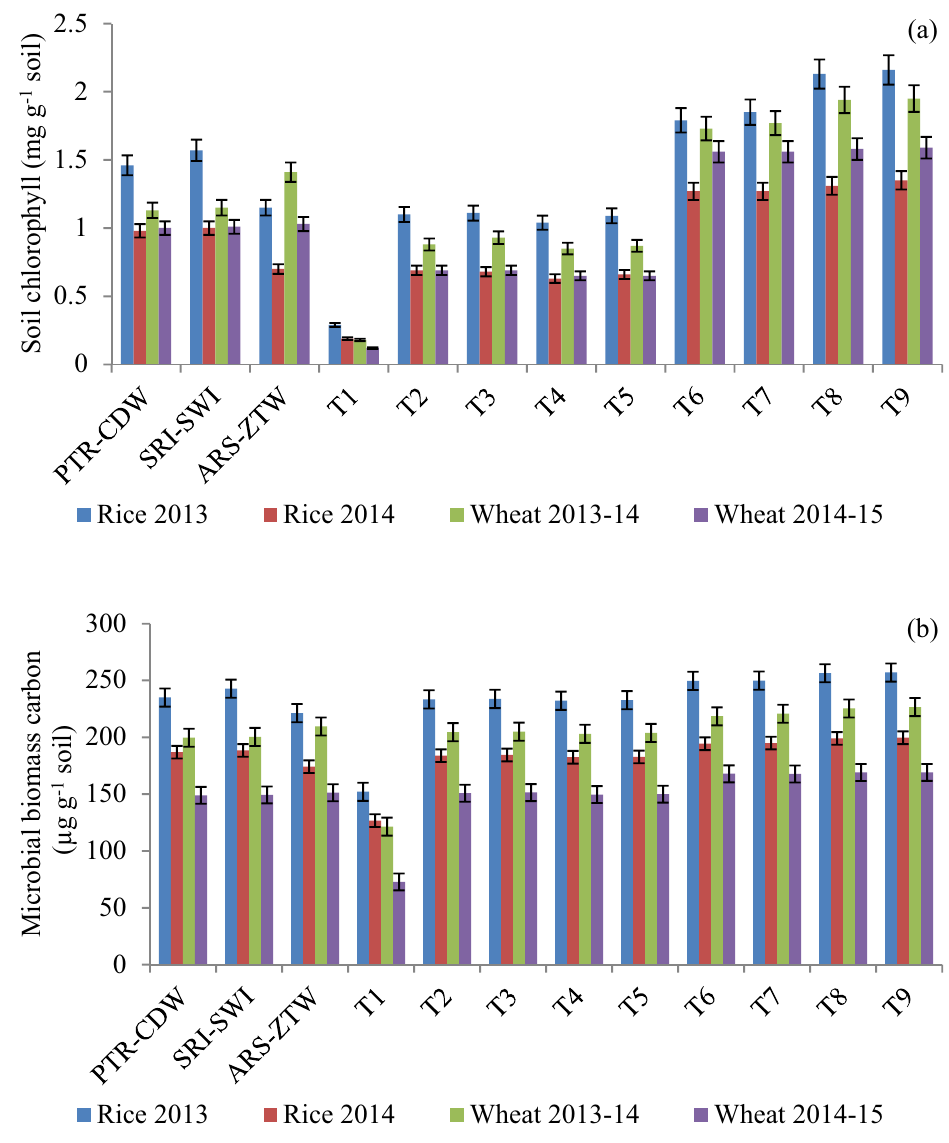
Figure 1. Variation in soil chlorophyll ( a ) and microbial biomass carbon ( b ) in rice and wheat at 60 and 70 days after sowing, respectively due to CETs and nutrient management